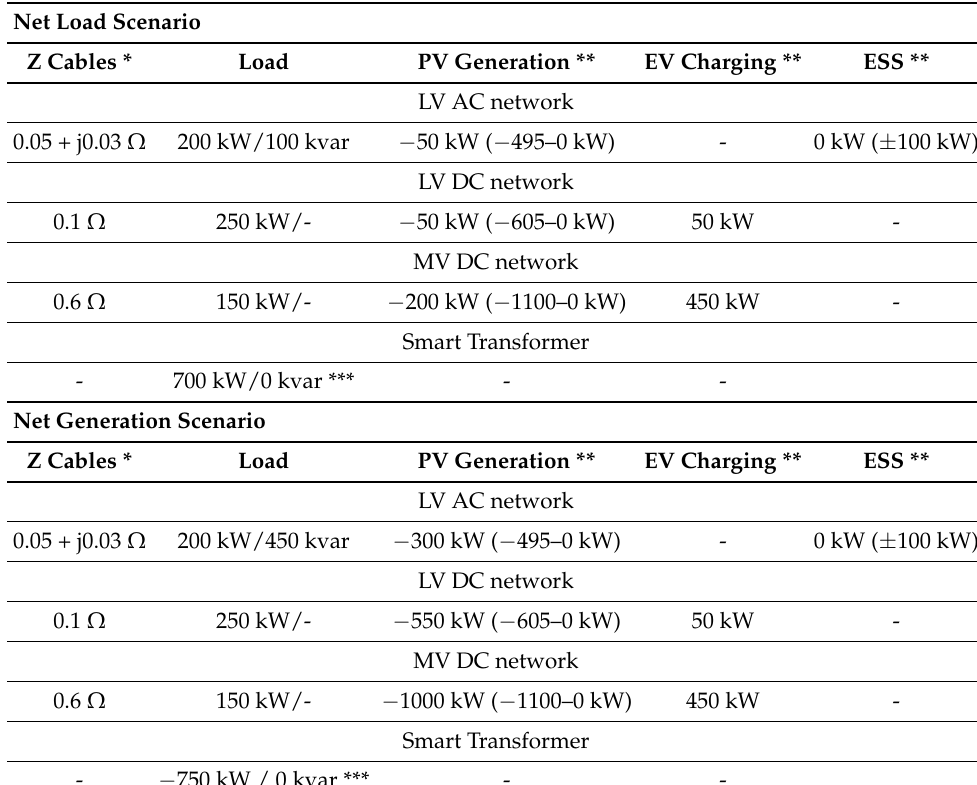
Table 4. Steady-state conditions and operation limits (nominal voltage and frequency).